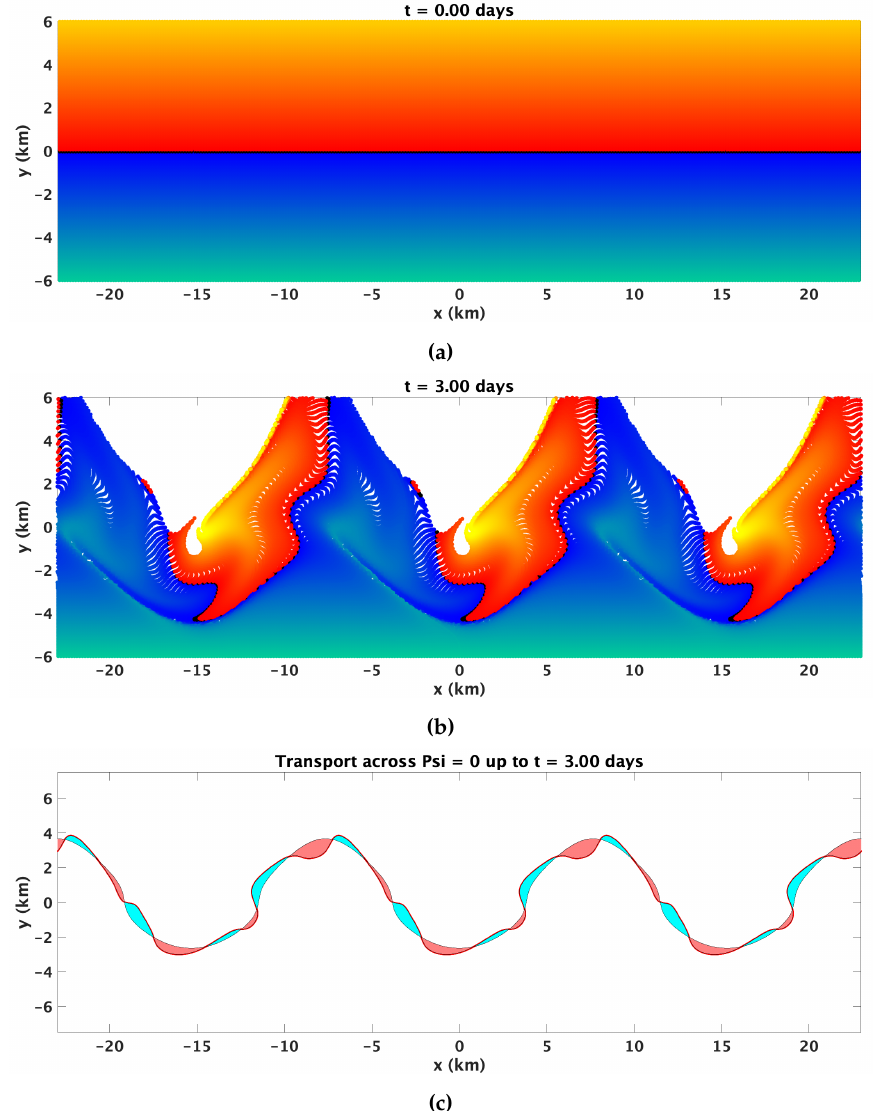
Figure 4. ( a ) Initial positions and ( b ) positions after three days of a set of sample trajectories, colored by their initial y -position. ( c ) Water masses transported off-shore (cyan) and on-shore (red) across Ψ = 0 over the analysis period of three